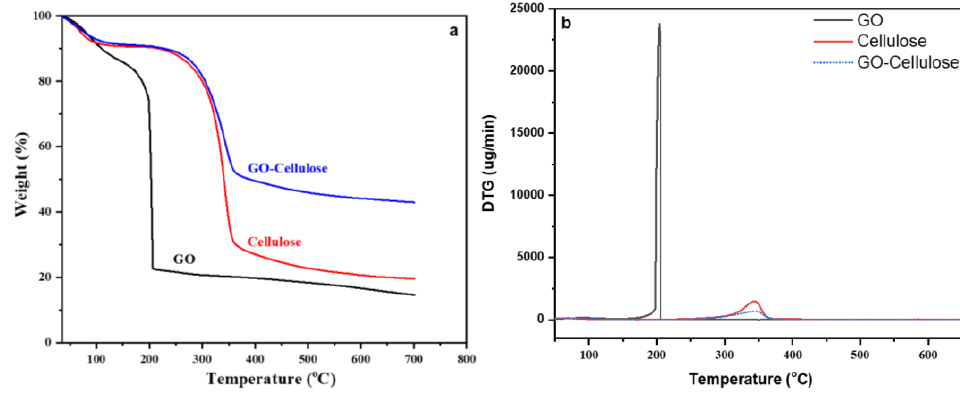
Figure 5. TGA (a) and DTG curve of GO, extracted cellulose, and GO–cellulose composite. Figure 5. TGA ( a ) and DTG curve of GO ( b ), extracted cellulose, and GO–cellulose composite. Table 2. Specific surface area and porous structure parameters of extracted cellulose and GO–cellulose